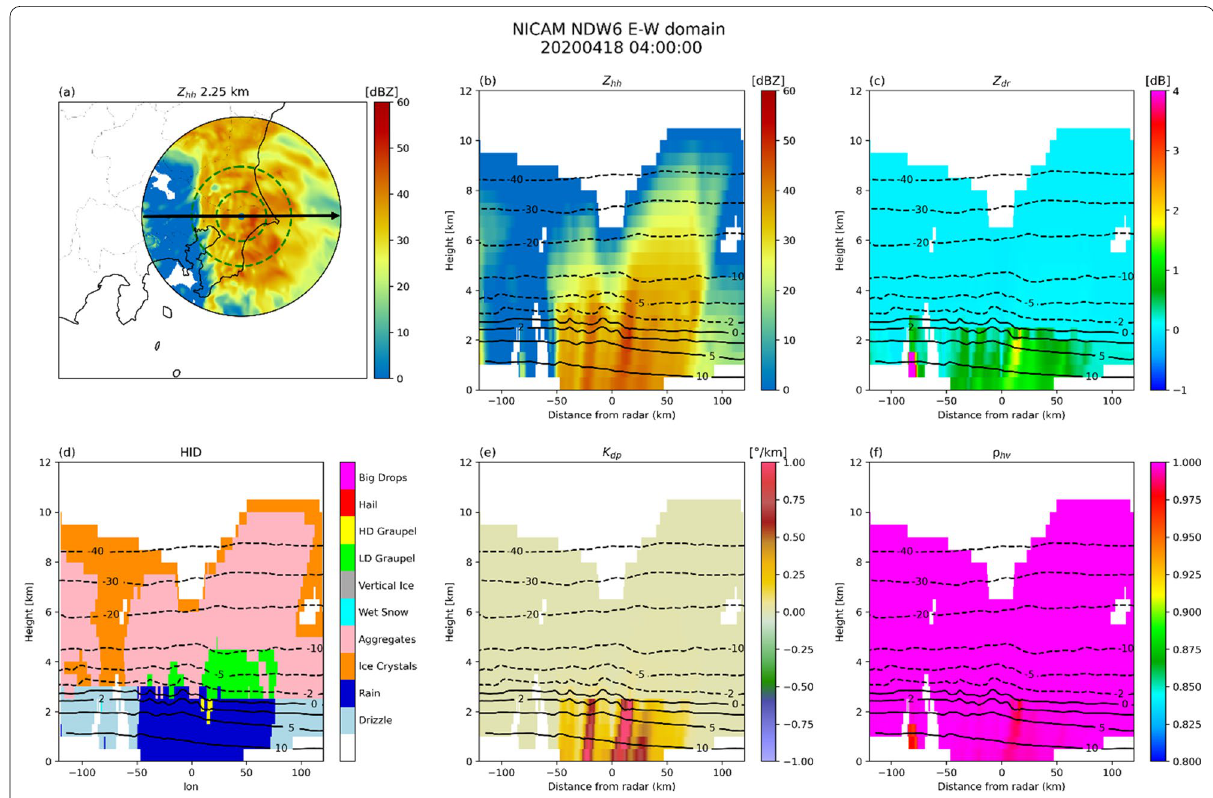
Fig. 8 The same as Fig. 6, but for the results of the NICAM-NDW6